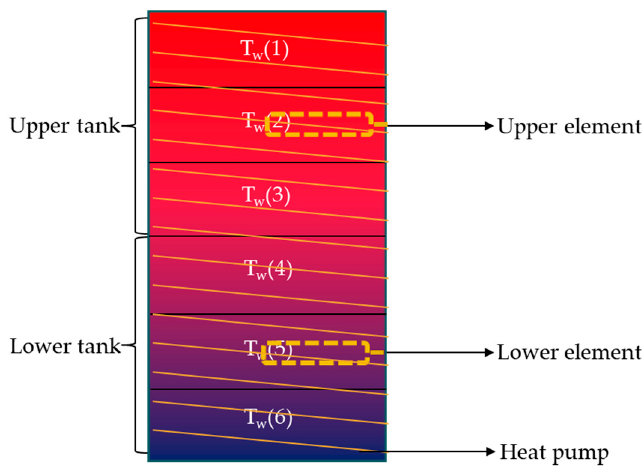
Figure 2. The diagram of the water heater.